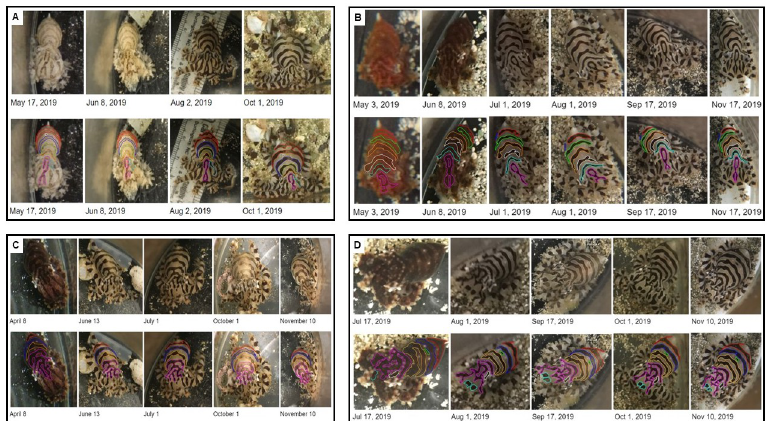
Fig 5. Timeline of O . chierchiae individuals showing consistent body patternings. The bottom row of each panel duplicates these photographs, with analogous pattern components color coded. (A) Timeline of O . chierchiae individual (hatched Nov 12, 2018) over a 5 month time span. (B) Timeline of O . chierchiae individual (hatched May 6, 2019) over a 6 month time span. (C) Timeline of O . chierchiae individual (hatched Nov 26, 2018) over a 7 month time span. (D) Timeline of Octopus individual (hatched May 6, 2019) over a 4 month time